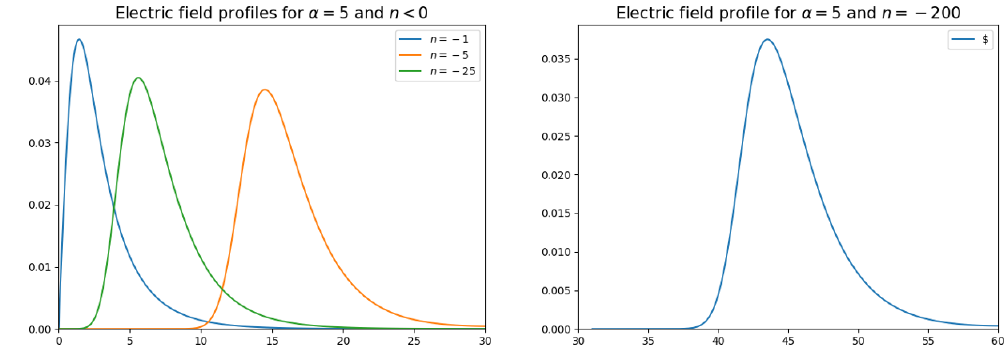
Figure 3 . The electric (cid:12)eld has support only at the edge of the vortex implying a ring-like pro(cid:12)le. The width of the transition region remains (cid:12)xed as j n j is cranked up.